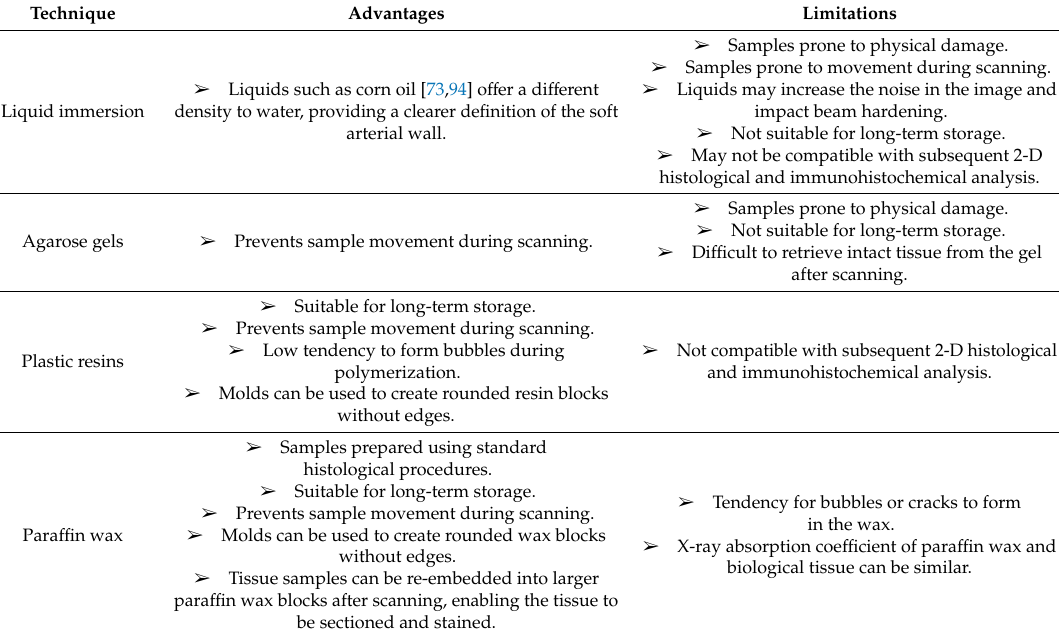
Table 3. Overview of di ff erent sample preparation techniques for µ